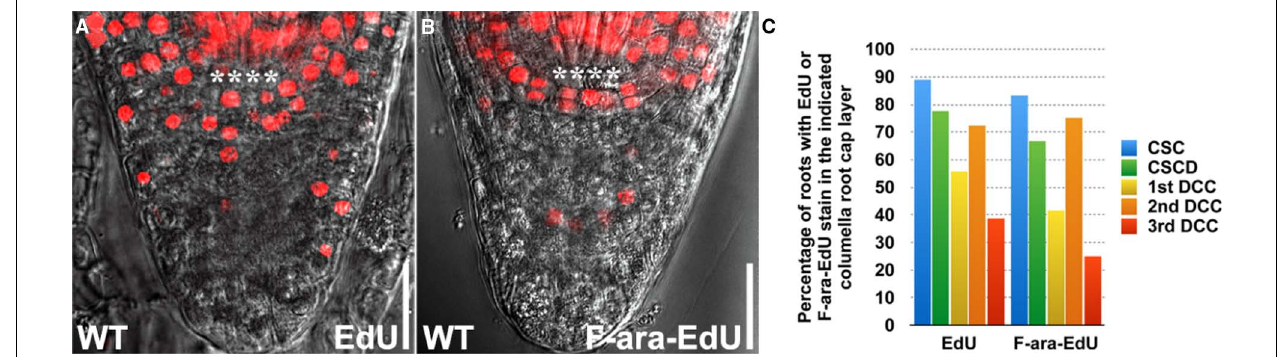
columella root cap stem cells; CSCD: layer of differentiating columella root cap stem cell daughters; 1st DCC: 1st layer of fully differentiated columella root cap cells; 2nd DCC: 2nd layer of fully differentiated columella root cap cells; 3rd DCC: 3rd layer of fully differentiated columella root cap cells. Scale bars: 20 m